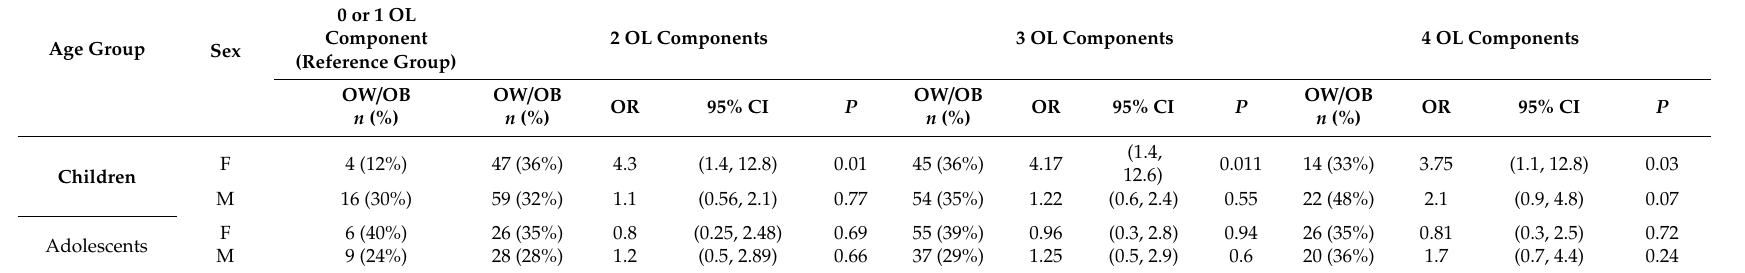
Table 7. Risk association for OW / OB according the cumulative e ff ect of OL components in Mexican children and